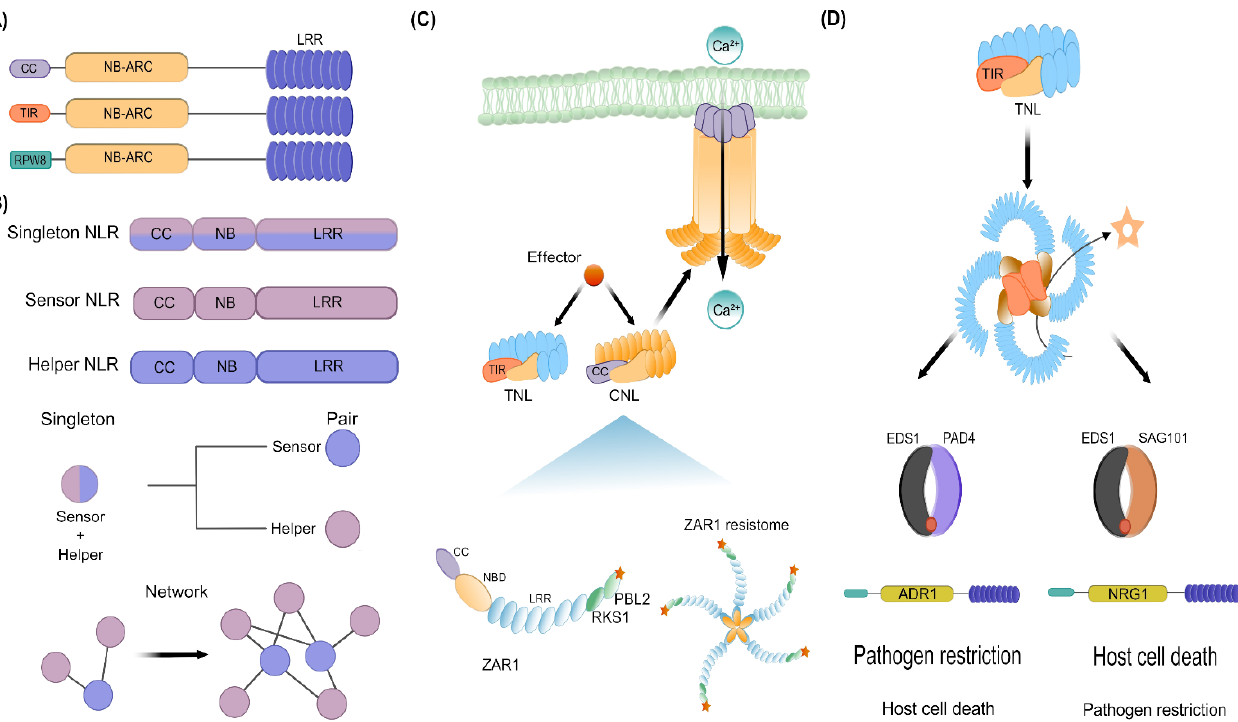
Figure 3. An overview of NLR-mediated ETI. ( A ) Classification of NLRs according to their N-terminal domains: CNLs, TNLs, and RNLs. ( B ) An overview of NLRs functioning as a singleton, pair or part of a network. ( C ) Perception of effectors by CNLs and TNLs is depicted, showing the mechanism of ZAR activation as an example of the CNL-mediated immunity. ( D ) TNL-mediated immunity is mediated by two modules (EDS1-PAD4-ADR1 and EDS1-SAG101-NRG1), deriving in two opposite outputs. See the main text for details. The network depicted in 3B was adapted with permission from [84], whereas the lower section of 3D was adapted with permission from [85]. Created with Inkscape (https://inkscape.org) and GIMP v2.10.24